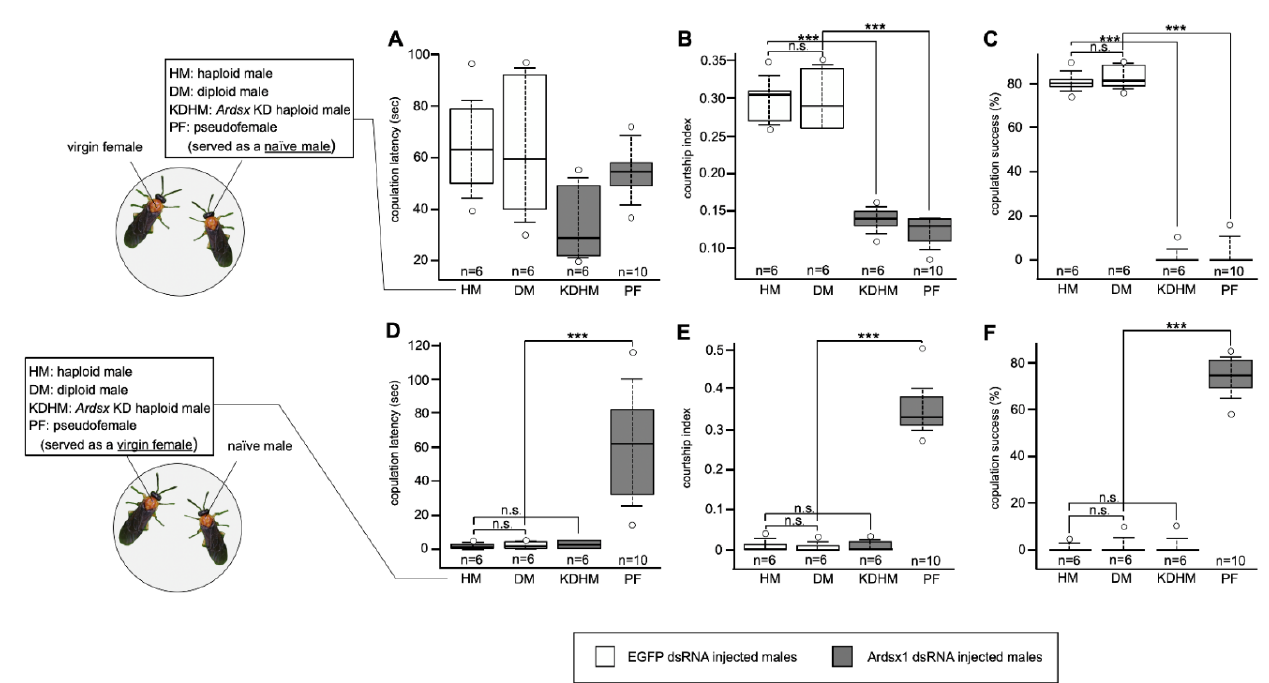
Figure 5. Effects of Ardsx knockdown on sexual behavior. ( A – C ) To evaluate whether Ardsx -knockdown males copulated with wild-type virgin females, either an Ardsx -knockdown haploid male or a pseudofemale (= Ardsx -knockdown diploid male) was placed with a virgin female. ( A ) Copulation latency, the time it takes for a male to initiate copulation with a virgin female; ( B ) the courtship index, the fraction of time spent in any aspect of courtship during the first 10 min of the assay; and ( C ) copulation success, the percentage of pairs that copulated within the first 1 h, were compared among different types of males. ( D , E ) To examine whether wild-type naïve males were attracted by Ardsx -knockdown haploid males or pseudofemales and copulated with them, a naïve male was put together either with an Ardsx -knockdown haploid male or a pseudofemale, and ( D ) copulation latency, ( E ) the courtship index, and ( F ) copulation success were recorded. The values shown by each sample and their distributions were represented by box-and-whisker plot. *** Significant difference at the 0.01 level (Mann – Whitney U test) compared with the negative control haploid males. n.s means no significant difference between two groups (Mann – Whitney U test).